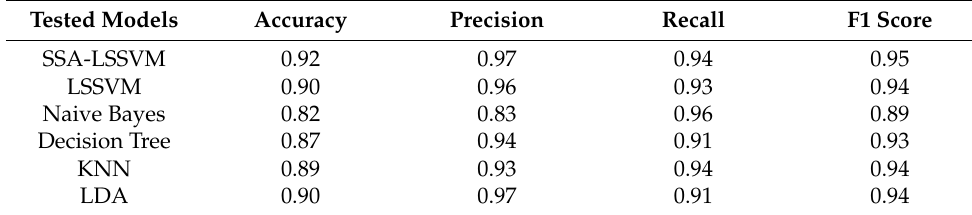
Table 8. AMT prediction model performance.